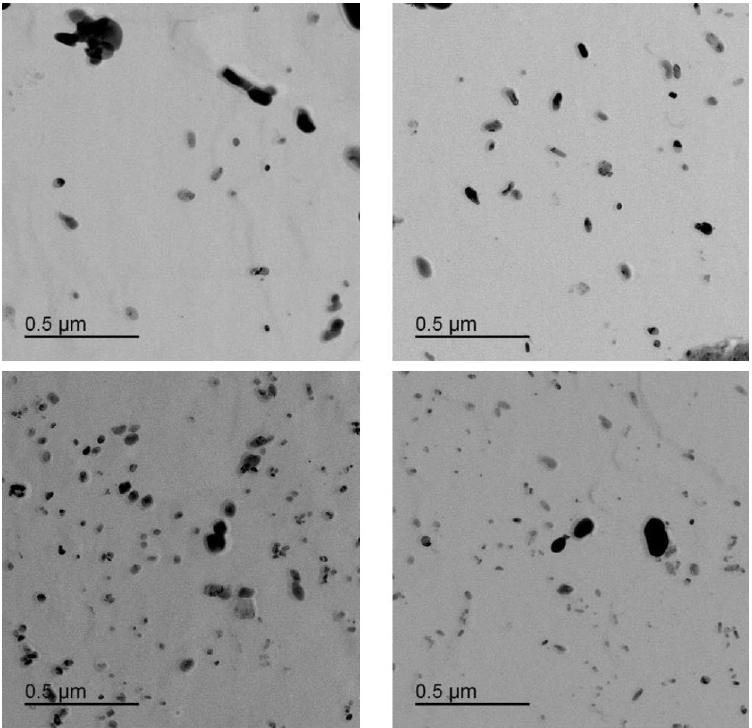
Figure A5. Failed crept cross-weld specimen 91-HAZ-3-5 600 °C 112 MPa 3216 h (sample B). TEM images on a carbon extraction replica at 100,000X.